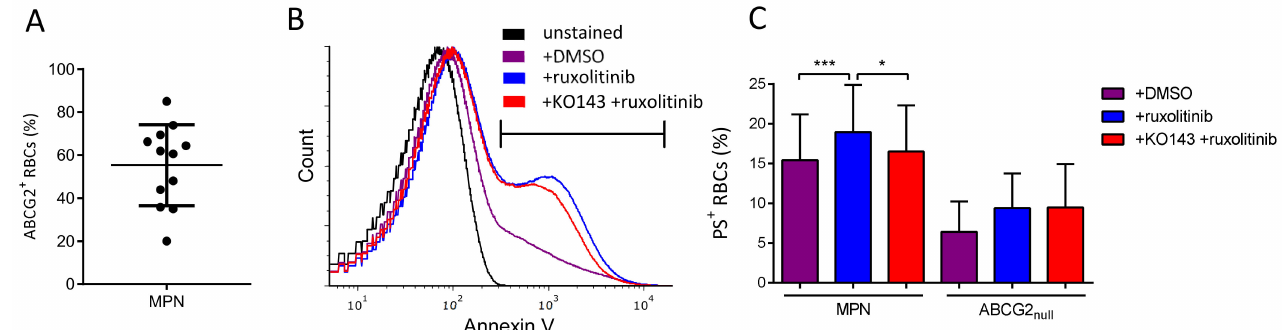
Figure 3. ABCG2 inhibition reduces ruxolitinib-induced PS exposure on MPN RBCs. ( A ) Flow cytometry analysis of ABCG2 expression presented as percentage of ABCG2-positive (ABCG2 + ) RBCs, means with SDs. ( B ) Representative flow cytometry histograms of PS exposure measured by annexin V in unstained MPN RBCs (black) and in MPN RBCs treated in vitro with DMSO (violet), ruxolitinib (blue), and KO143 + ruxolitinib (red). ( C ) Flow cytometry analysis of PS exposure measured using annexin V on MPN and ABCG2 null RBCs treated with DMSO or 50 µ M ruxolitinib for 72 h with or without 0.01 µ M KO143 pre-treatment. Wilcoxon test, * p < 0.05, *** p <